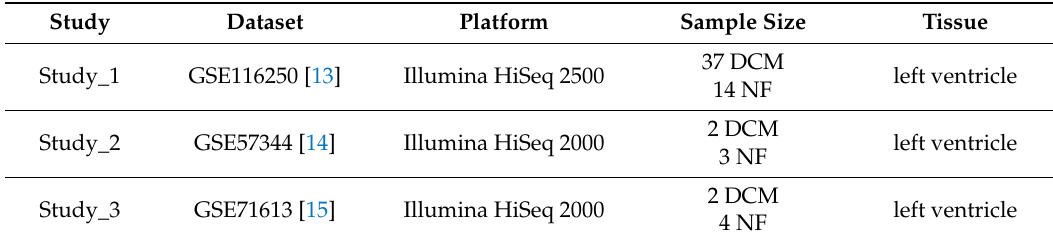
Table 1. Summary of GEO datasets for the